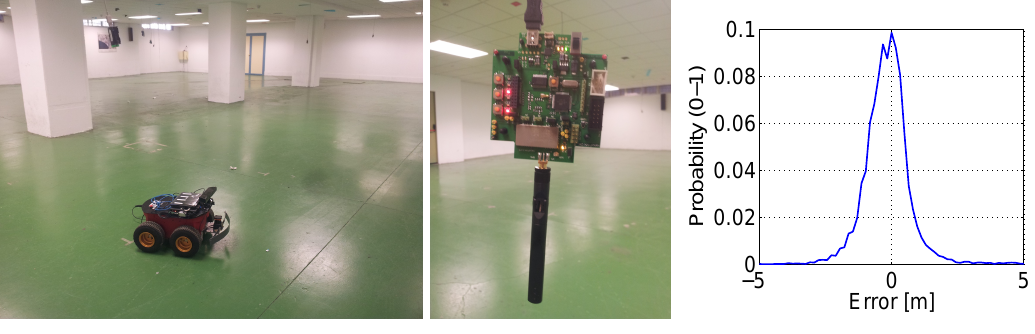
Figure 5. ( Left ) Picture of the CONET Integrated Testbed taken in the experiments; ( center ) Nanotron NanoPAN range sensors used in the experiments; ( right ) experimental characterization of range errors of Nanotron NanoPAN devices.